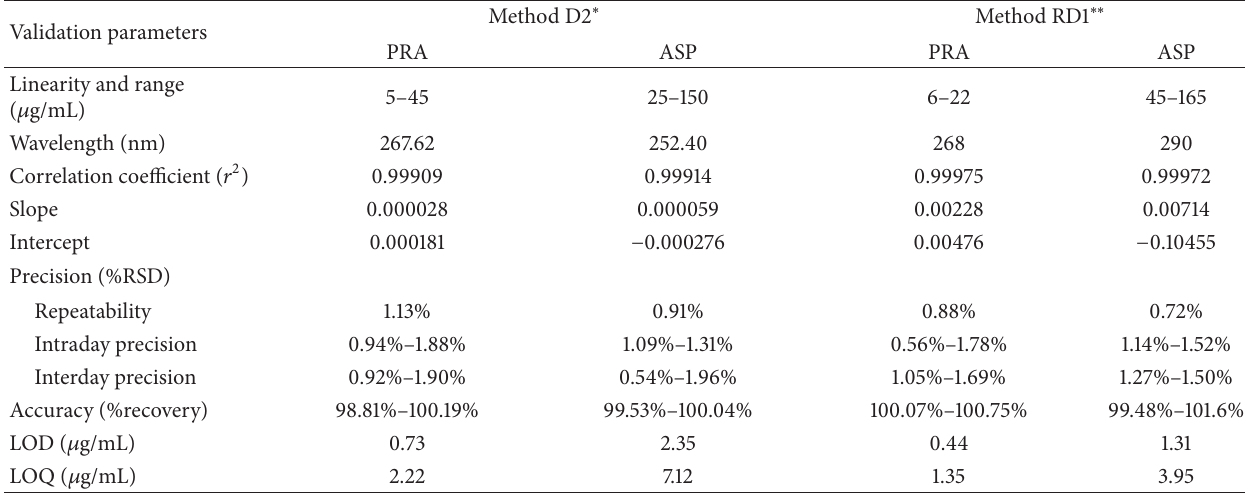
Table 1: Validation parameters for second order and ratio first order derivative spectrophotometric methods.